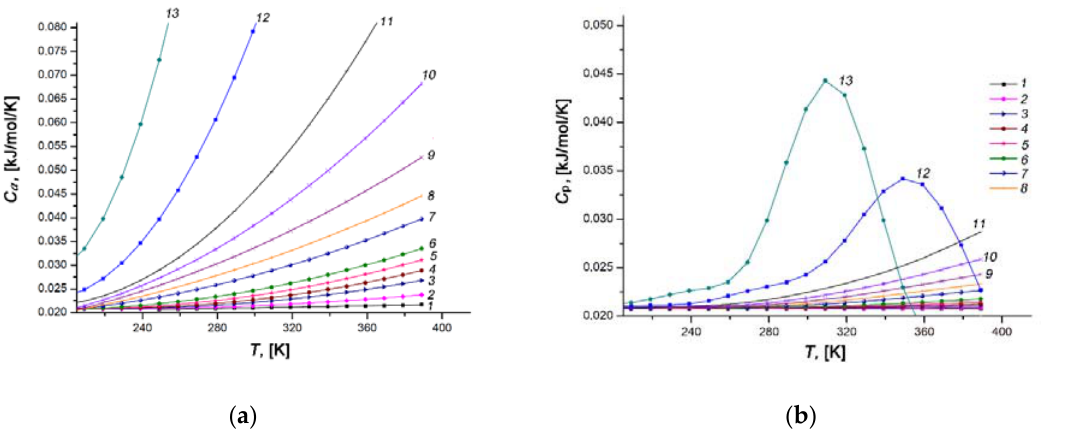
Figure 14. Temperature dependences of the differential molar isosteric heat capacities of the Xe/SiC-AC adsorption system ( a ) and the xenon gaseous phase ( b ) at the values of xenon adsorption, a, mmol/g: 0.1 (1), 1.5 (2), 2.5 (3), 3.0 (4), 3.5 (5), 4.0 (6), 5.0 (7), 5.5 (8), 6.0 (9), 6.5 (10), 7.0 (11), 8.0 (12), 9.0